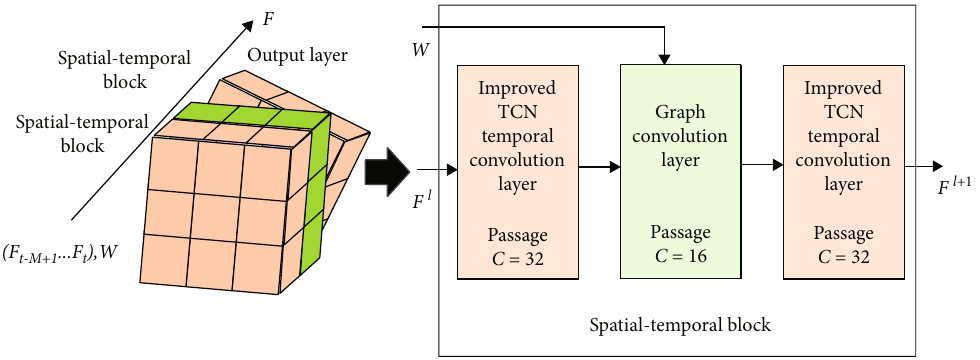
Figure 8: Spatiotemporal block and output connection